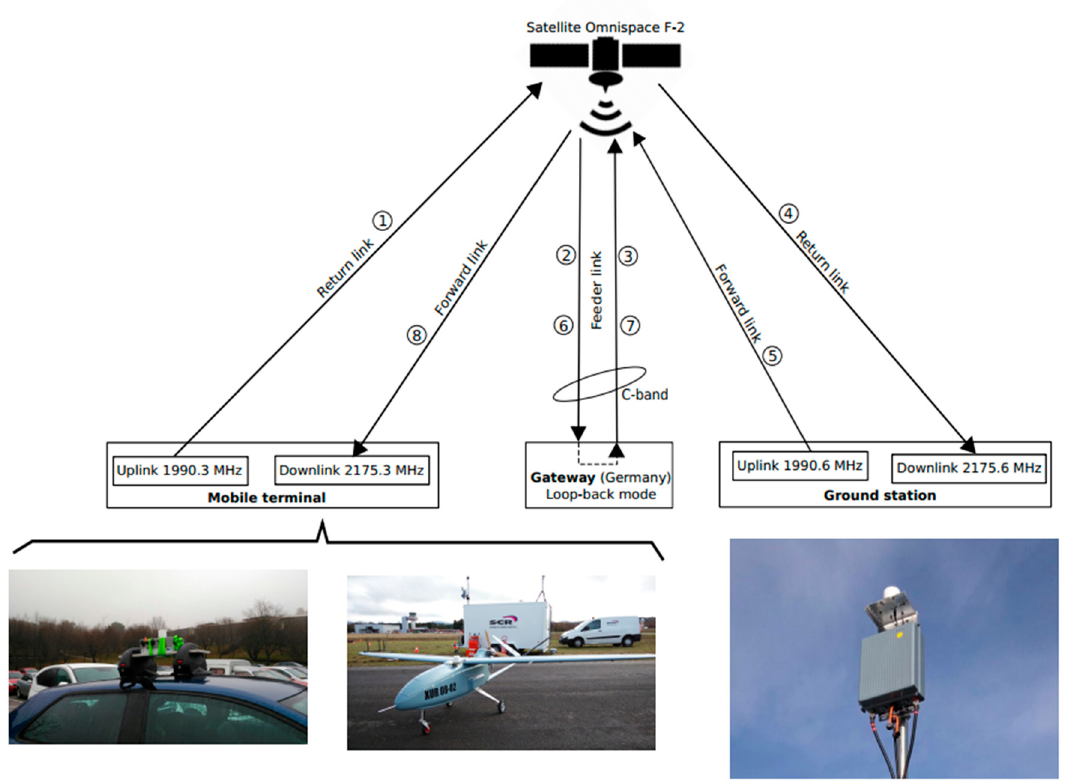
Figure 2. Block diagrams of the satellite communications system created in Tactica